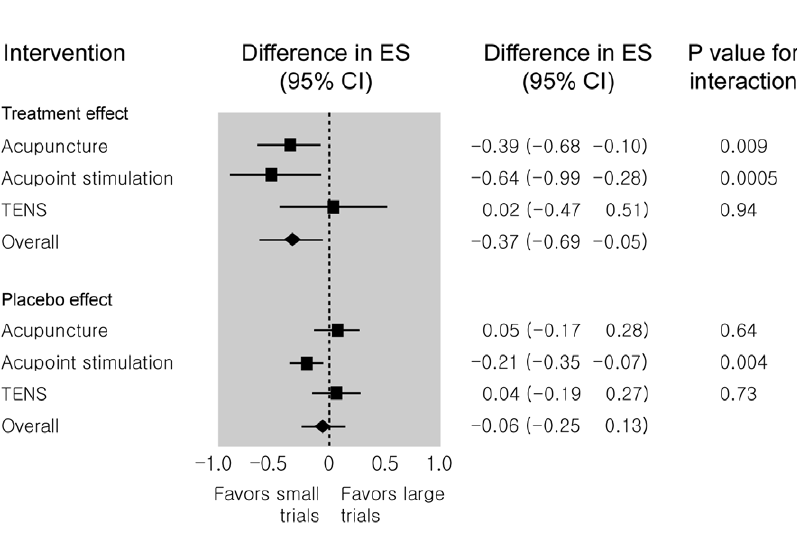
Figure 2. Difference in effect sizes between large trials with at least 100 patients per arm and small trials with fewer than 100 patients. ES = effect size.